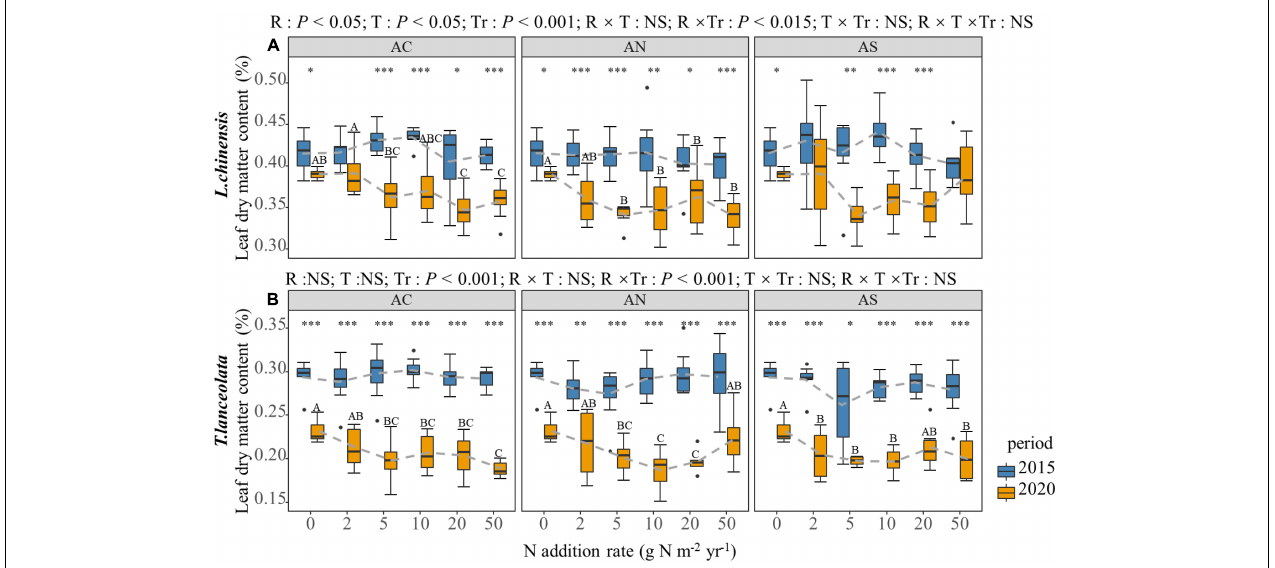
FIGURE 5 | Effects of short- and long-term nitrogen deposition on LDMC of two species: (A) Leymus chinensis ; (B) Thermopsis lanceolata . The three-way ANOVA was used to test the effects of Pr, T and R on LDMC. The effects of the nitrogen compound type alone and with nitrogen addition rate and year on LDMC are not significant (NS, P > 0.05), thus one-way ANOVA (Tukey’s HSD) and t -tests are used to test the effects of nitrogen addition rate and year on LDMC. Different lower-case and upper-case letters indicate significant differences ( P < 0.05) in LN among nitrogen addition rate in the 2015 and 2020 plots, respectively. The asterisk above the picture indicates the significant difference between the two years under each nitrogen addition rate. Note: ∗ P < 0.05; ∗∗ P < 0.01; ∗∗∗ P < 0.001. CK: non-fertilizer control = 0, N1 = 2, N2 = 5, N3 = 10, N4 = 20, and N5 = 50 kg N ha − 1 yr − 1 ; AC (NH 4 HCO 3 ), AN (NH 4 NO 3 ), AS [(NH 4 ) 2 SO 4 ]. The gray dashed line is the connection of the mean value.